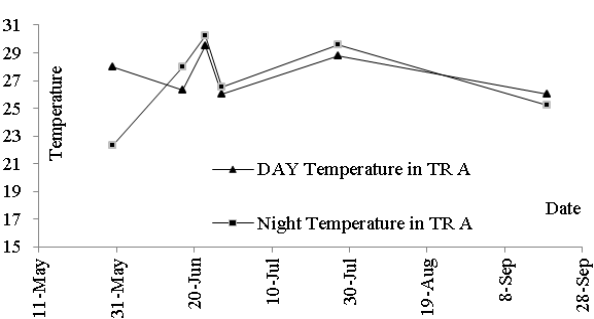
Figure 12: Averaged surface temperatures in control sample (treatment A), in day and night time